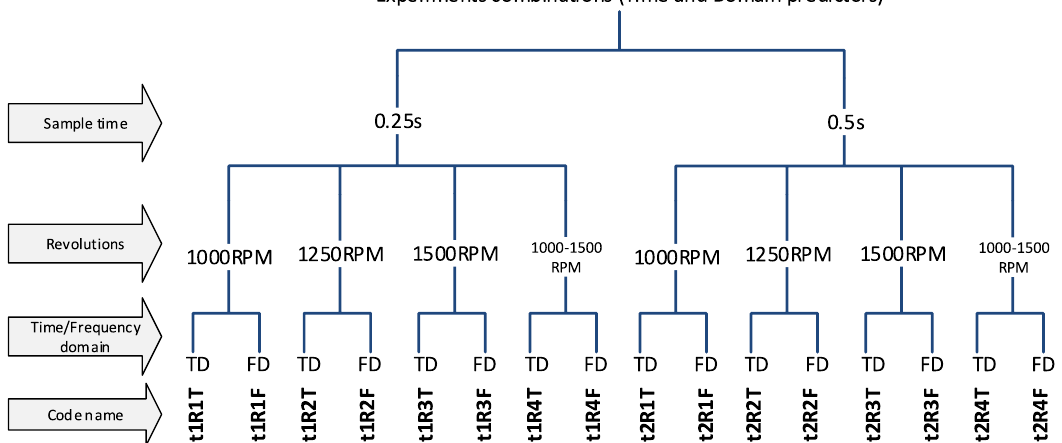
Figure 7. The code names of